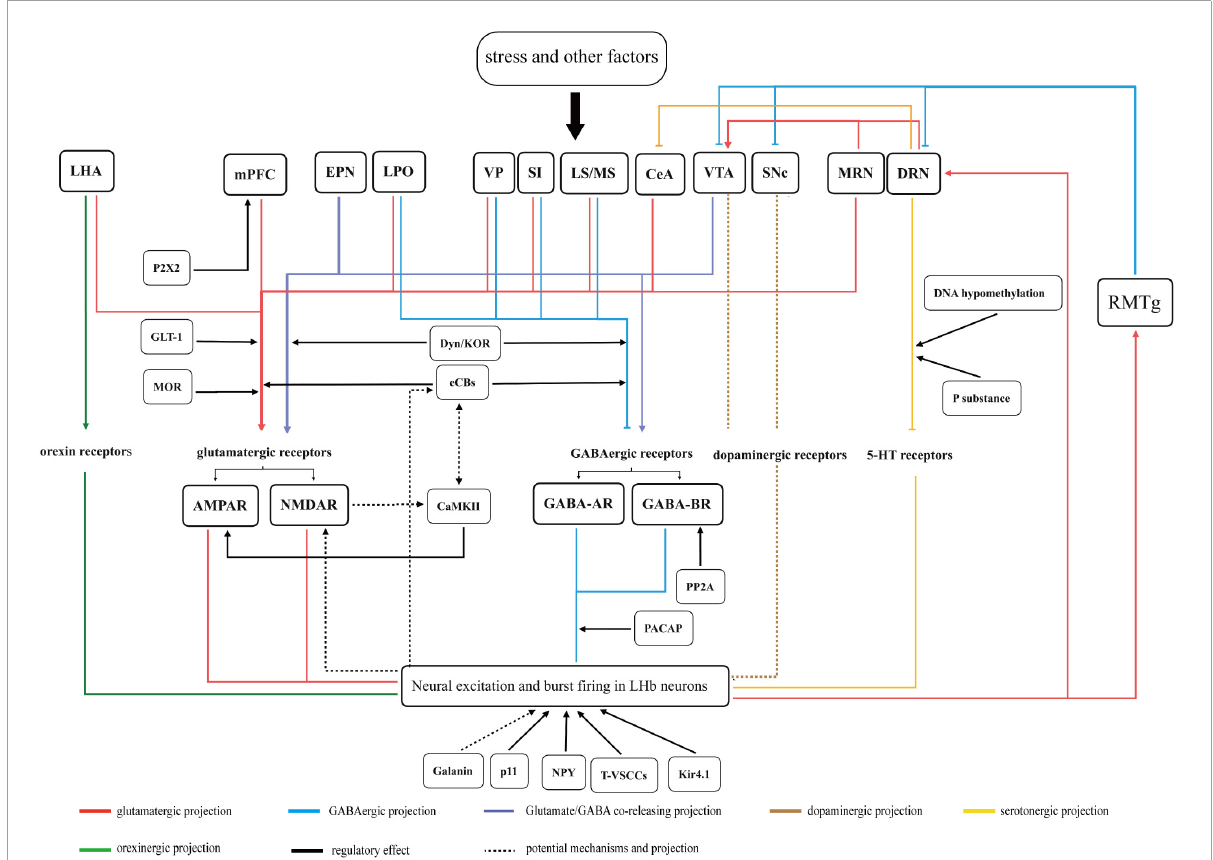
FIGURE3 A summary figure of the LHb variations and related mechanisms in depression is discussed in this review. Stress and other factors act on upstream regions. The anomalous projections from the upstream regions to LHb acts on various neurotransmitter receptors in LHb neurons. This results in neural excitation and burst firing in LHb neurons. Subsequently, overactive projecting neurons in LHb mediate dysfunction in monoaminergic nuclei via direct or indirect projections. Moreover, these downstream regions also project to LHb or its upstream regions, which are connected to form a network of neural projections. All the above factors eventually culminate in depressive-like symptoms in rodents. Related molecules and neuropeptides act on input neurons, receptors, and neurons in LHb and play different regulatory roles in the pathological processes of depression. The functional significance of parts of the regions remain uncertain are not represented in